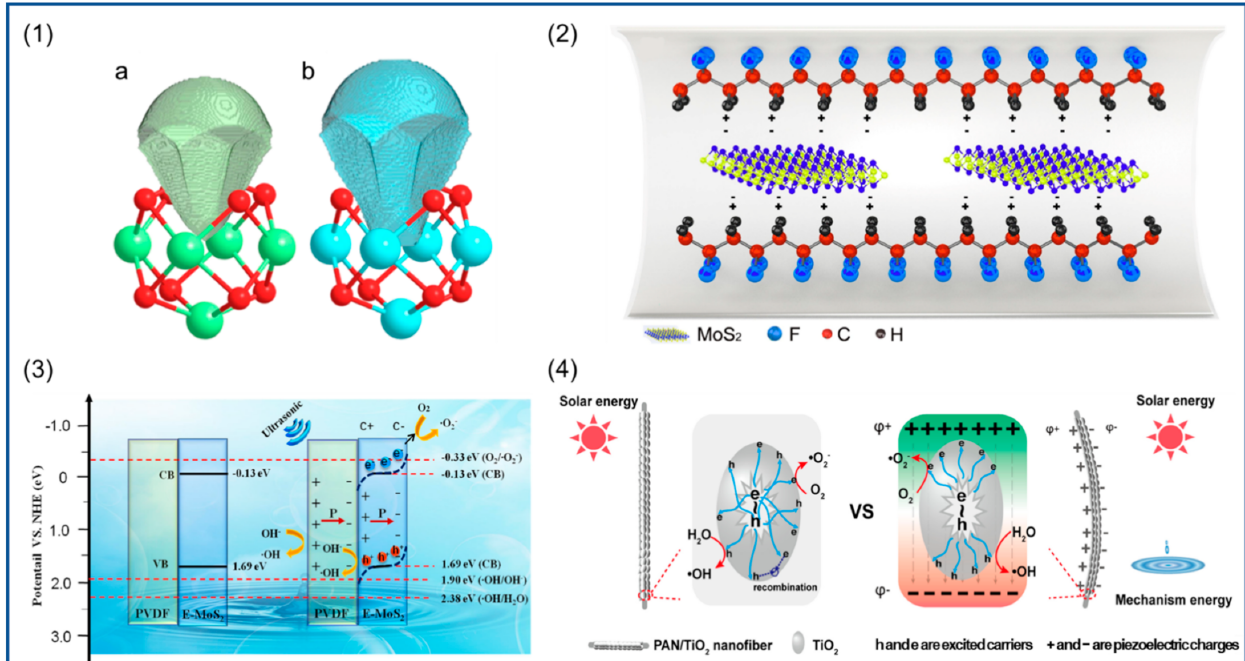
Figure 15. ELF basin analysis of the optimized geometry of ( 1 ) ( a ) Zr − oxo and ( b ) HF − oxo clusters. Reprinted with permission from Ref. [14], copyright 2021, John Wiley & Sons, Ltd. ( 2 ) Schematic diagram of β -phase formation in MoS 2 /PVDF. Reprinted with permission from Ref. [192], copyright 2021, Elsevier. ( 3 ) the mechanism of interfacial charge transfer process under the influence of band structure and band bending. Reprinted with permission from Ref. [192], copyright 2021, Elsevier. ( 4 ) Piezoelectric photocatalysis principle of TiO 2 /PVDF. Reprinted with permission from Ref.